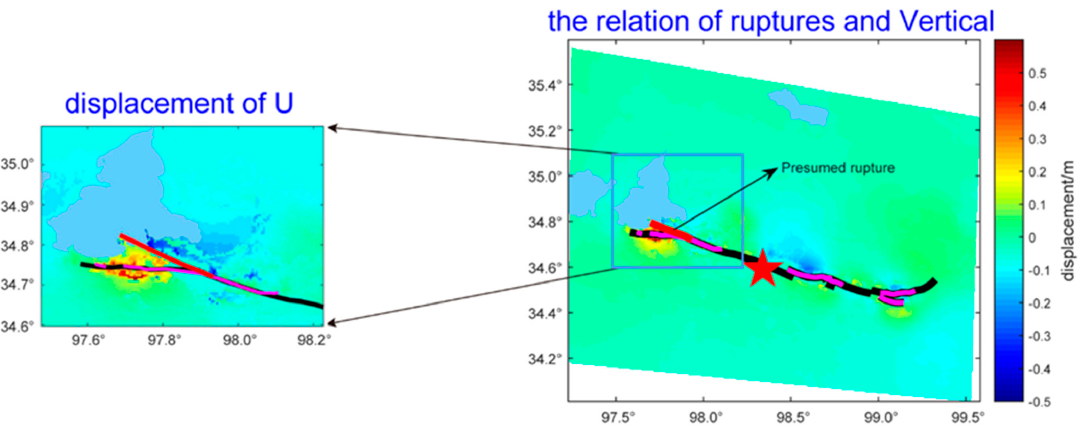
Figure 5. The vertical component displacement of the presumed rupture. (The red line is the presumed rupture that caused the vertical deformation, the purple line is the actual field investigation of the surface rupture, and the black line is the complete rupture according to the actual rupture). Combining the deformation result with the fi eld survey, the above analysis results